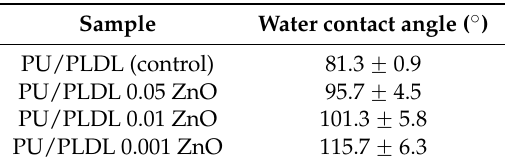
Table 1. Water contact angle measurements of PU/PLDL blend cast films doped with different amounts of zinc oxide.